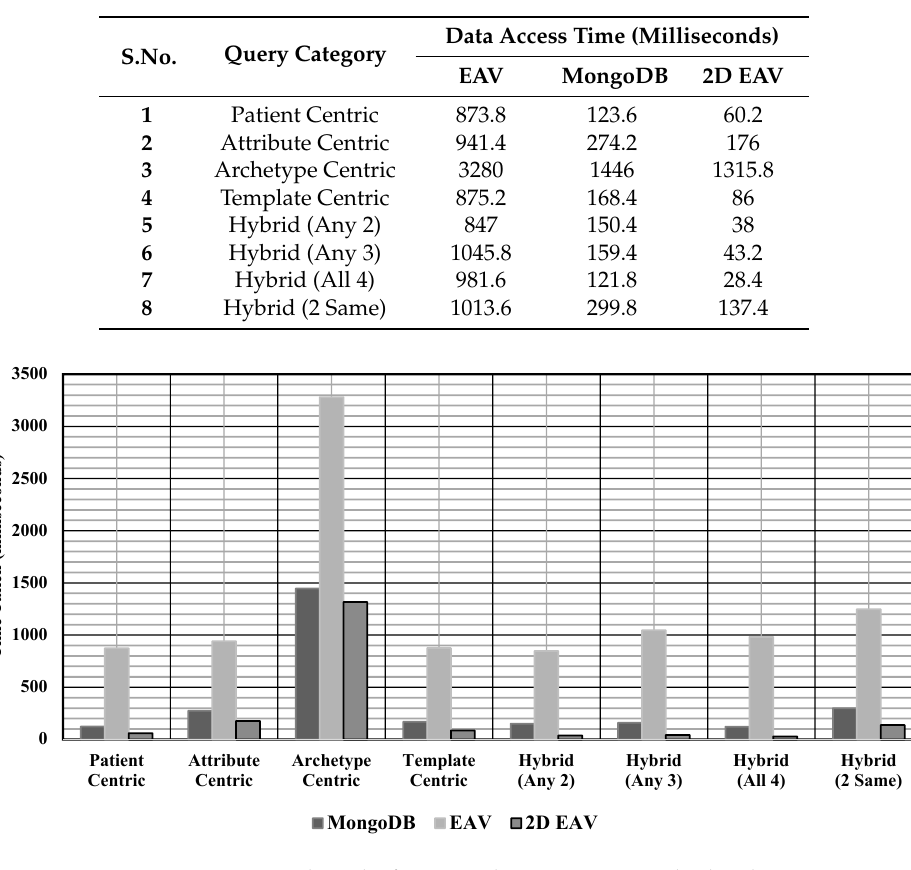
Figure 5. Experimental results for time taken to access standardized EHRs.